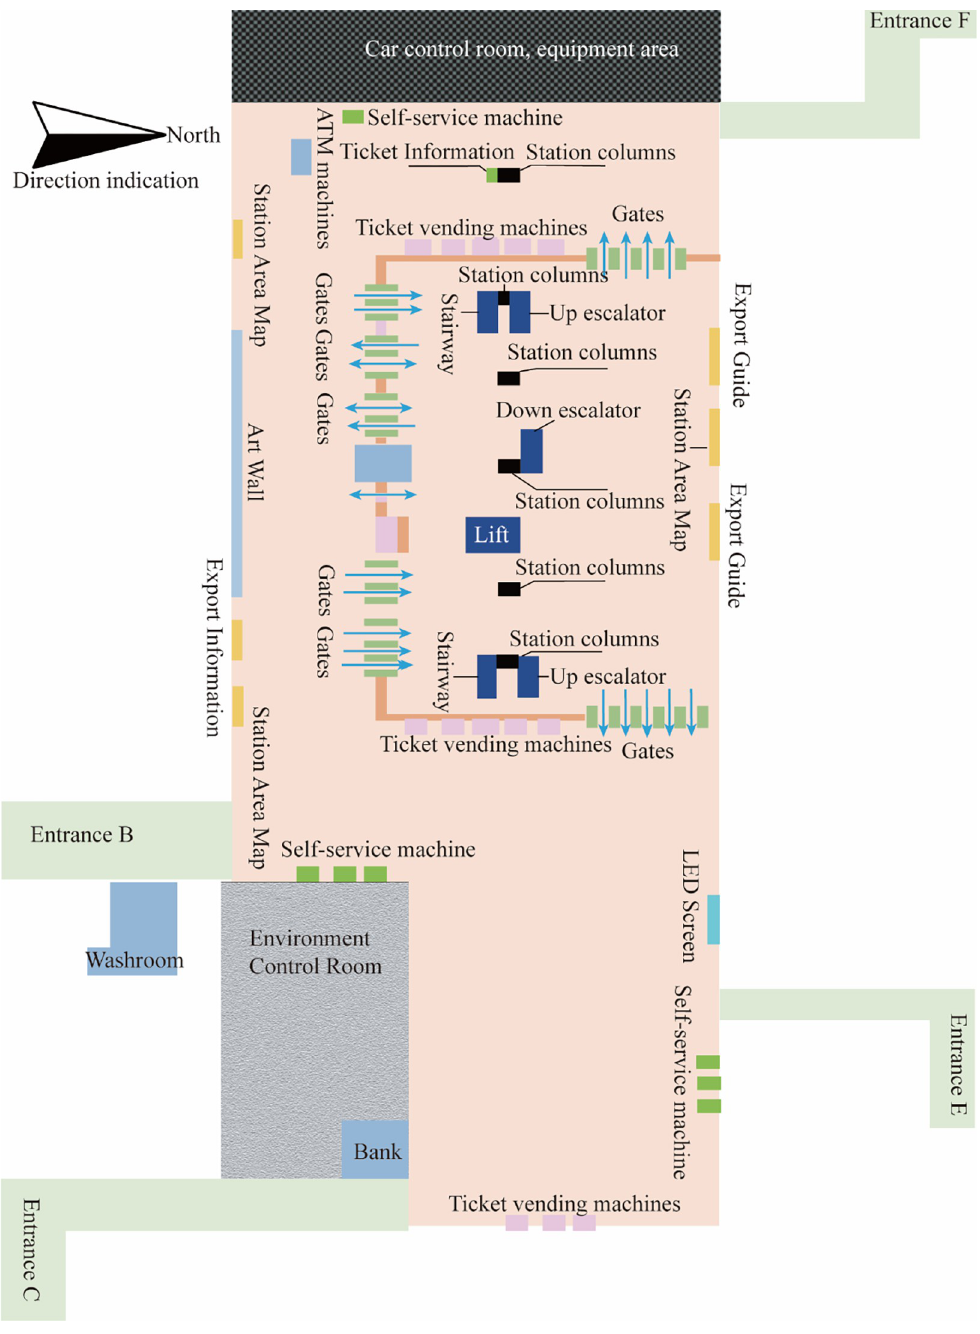
Fig 2. Subway station hall level